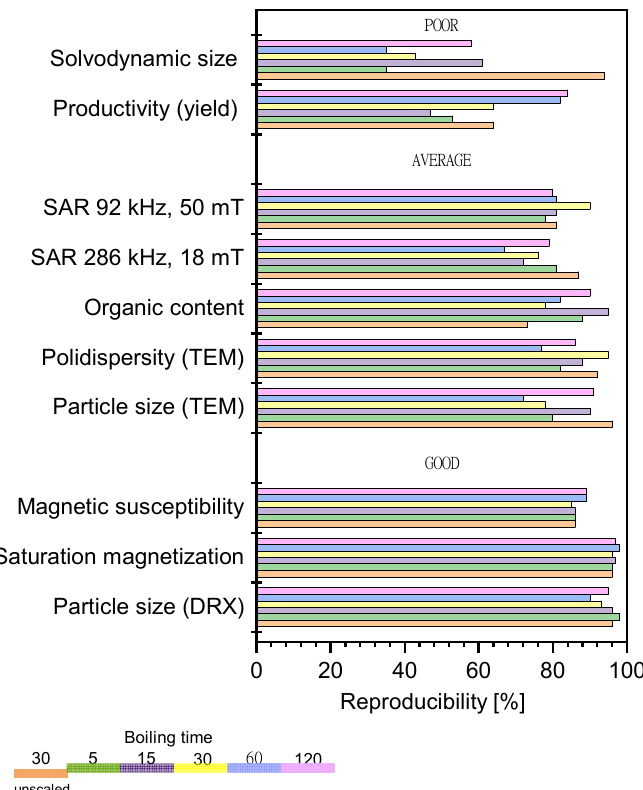
Figure 4. Reproducibility of the process and sample characteristics, as well as their dependence on the boiling time. The control parameters have been broadly classified in terms of reproducibility as poor (<60%), average (60–80%), and good (>80%).